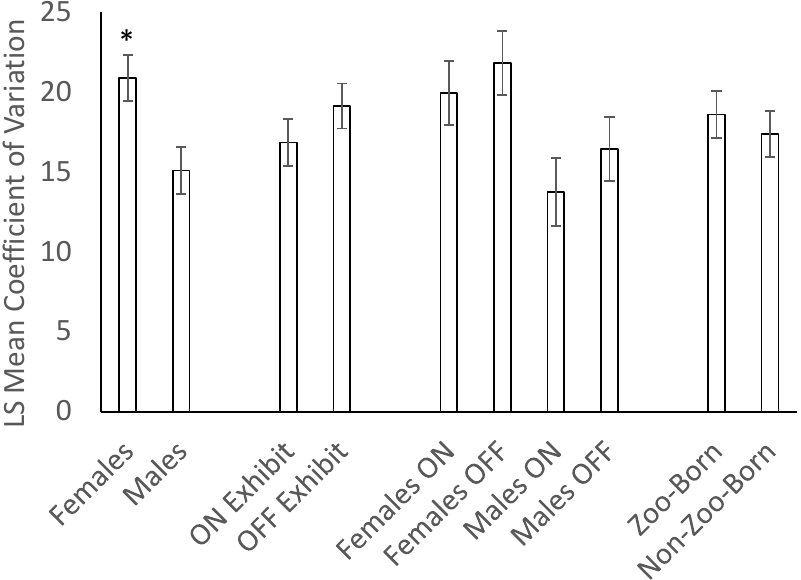
Figure 3. Mean coefficient of variation (CV) ± SEM of fecal glucocorticoid concentrations (N gpigs = 16, N CVs = 62) in guinea pigs in relation to sex, birth location, and housing location. Females displayed significantly greater variation in fecal glucocorticoid concentrations than males (* p < 0.01); no other effects were significant.